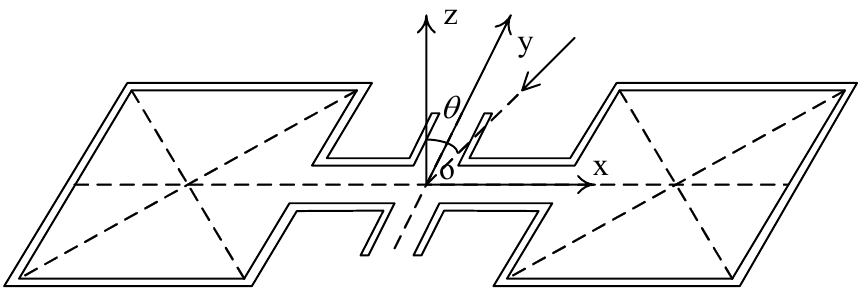
Figure 3. Schematic diagram of the sensitive